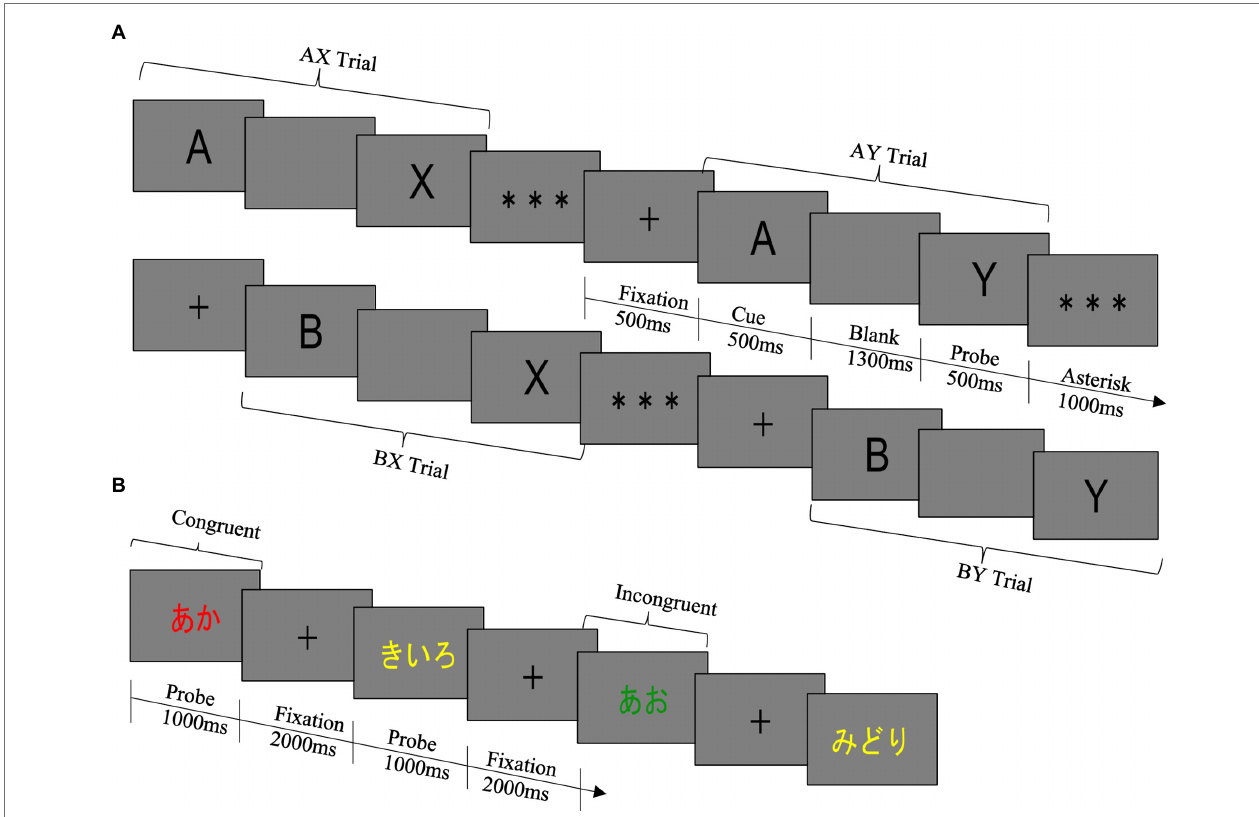
FIGURE 1 | (A) AX-CPT. The rule of the task was to press the target key only if A was followed by X. In all other trial types, the non-target key was required to be pressed. The target key was the left arrow key, and the non-target key was the right arrow key. In both the pre- and the post-test, the task was divided into two blocks, and the number of trials in each block was 100 trials. The pre-test consisted of blocks 1 and 2, and the post-test consisted of blocks 3 and 4. Within a block, the proportion of trial types was 70% for AX (true cue-correct probe) trials, 10% for AY (true cue-false probe) trials, 10% for BX (false cue-true probe) trials, and 10% for BY (false cue-false probe) trials, and the order in which each trial type was presented was completely random. In this study, the false cue stimulus and the false probe stimulus were randomly selected from letters except for the true cue stimulus “A” and the true probe stimulus “X.” The same letter was never used in the cue stimulus and the probe stimulus. The same letter was never used for both cue and probe stimuli. (B) Modified Stroop Task. The rule was to press the button corresponding to the ink color of the letter: d for red, f for blue, j for green, and k for yellow. The keys were marked with stickers of the corresponding color. In both the pre- and the post-test, the task was divided into three blocks, and the number of trials in each block was 80 trials. The pre-test consisted of blocks 1 to 3, and the post-test consisted of blocks 4 to 6. Within a block, the proportion of trial types was 70% for congruent trials and 30% for incongruent trials and the order in which each trial type was presented was completely